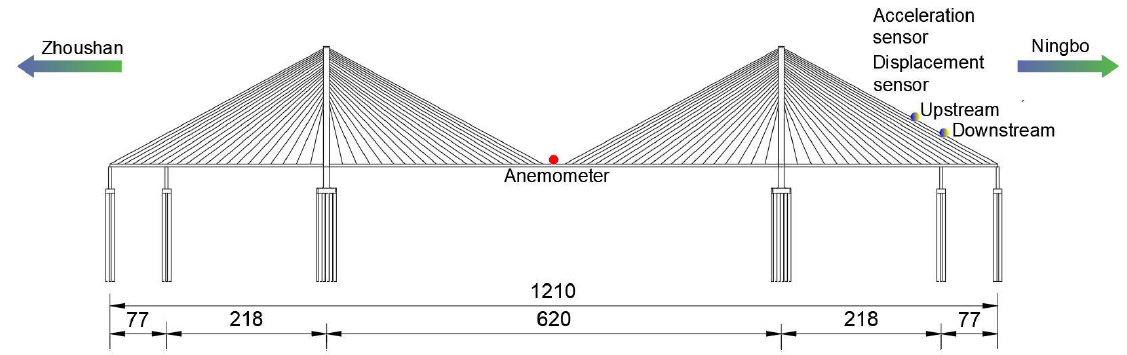
Figure 2. Sensor layout on the Jintang Bridge (in units of meters).